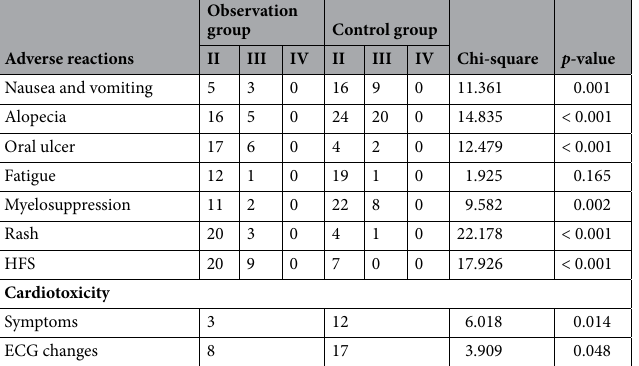
Table 5. Adverse reactions with a high incidence following the preoperative neoadjuvant chemotherapy (unit: case). HFS hand-foot